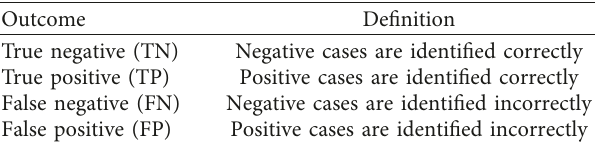
Table 4: Four cases of